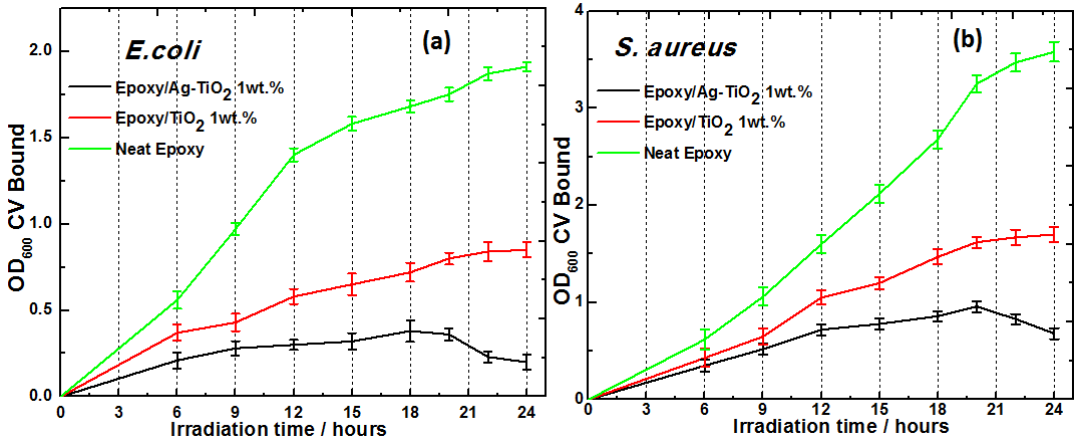
Figure 8. Growth curve for biofilm formation on neat resin, epoxy/TiO 2 and epoxy/Ag-TiO 2 composite of ( a ) E. coli and ( b ) S. aureus